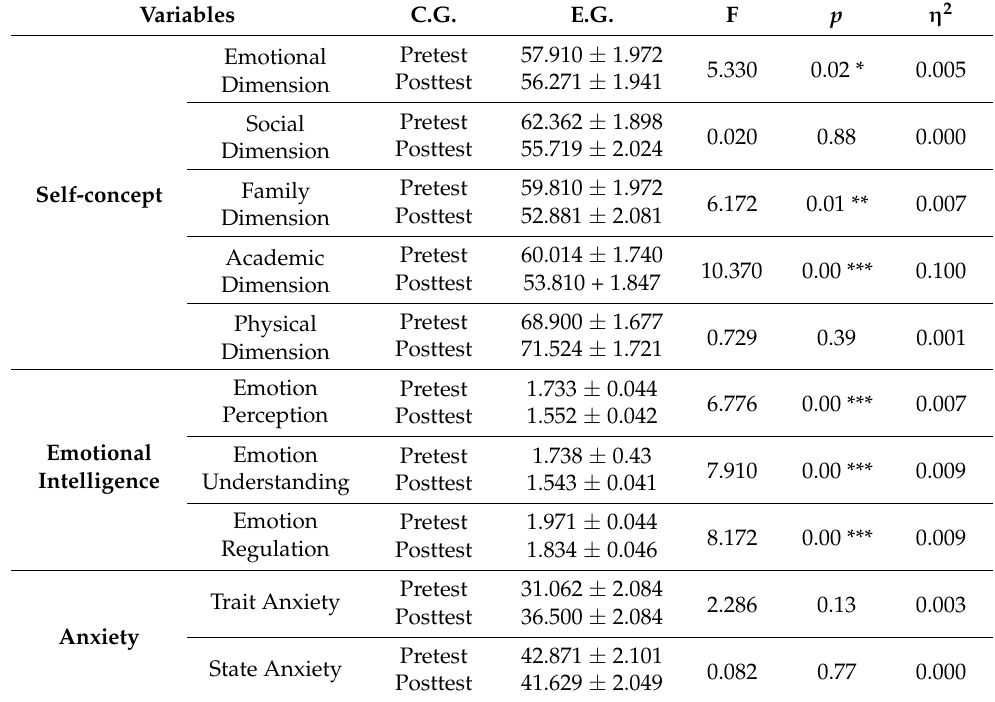
Table 7. Results of the repeated measures model for each variable of self-concept, emotional intelli- gence, and